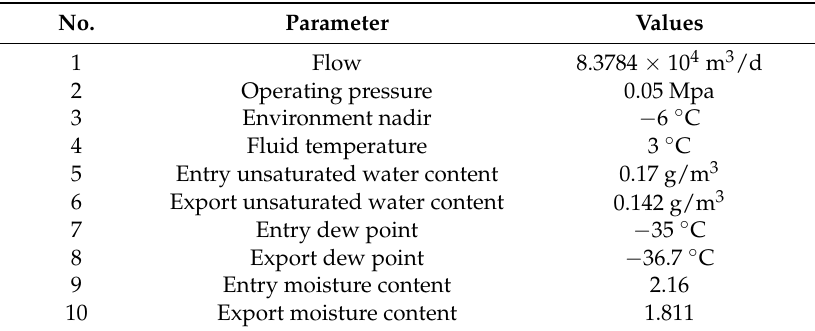
Table 2. Equipment operation